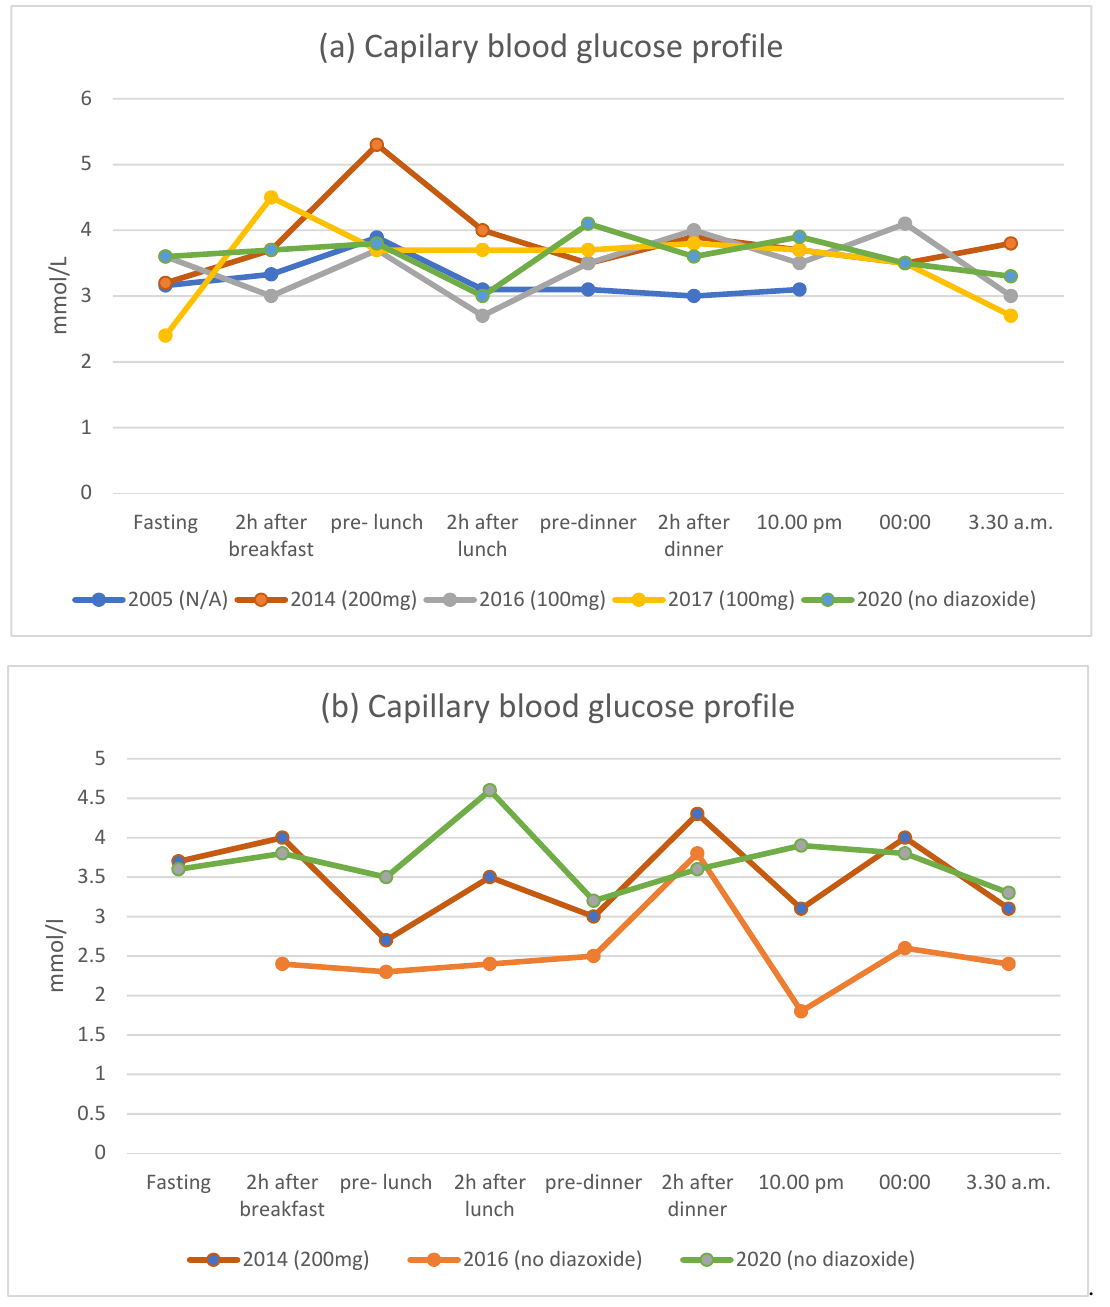
Figure 2. Capillary blood glucose profiles (mmol/L) of index patient I.1 ( a ) and his son II.1 ( b ) .